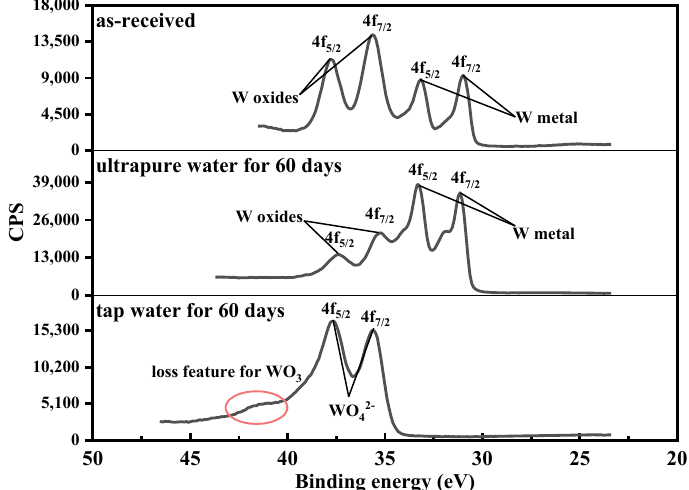
Figure 4. XPS spectra of the W 4f levels for as-received tungsten and tungsten in ultrapure water and tap water for 60 days.